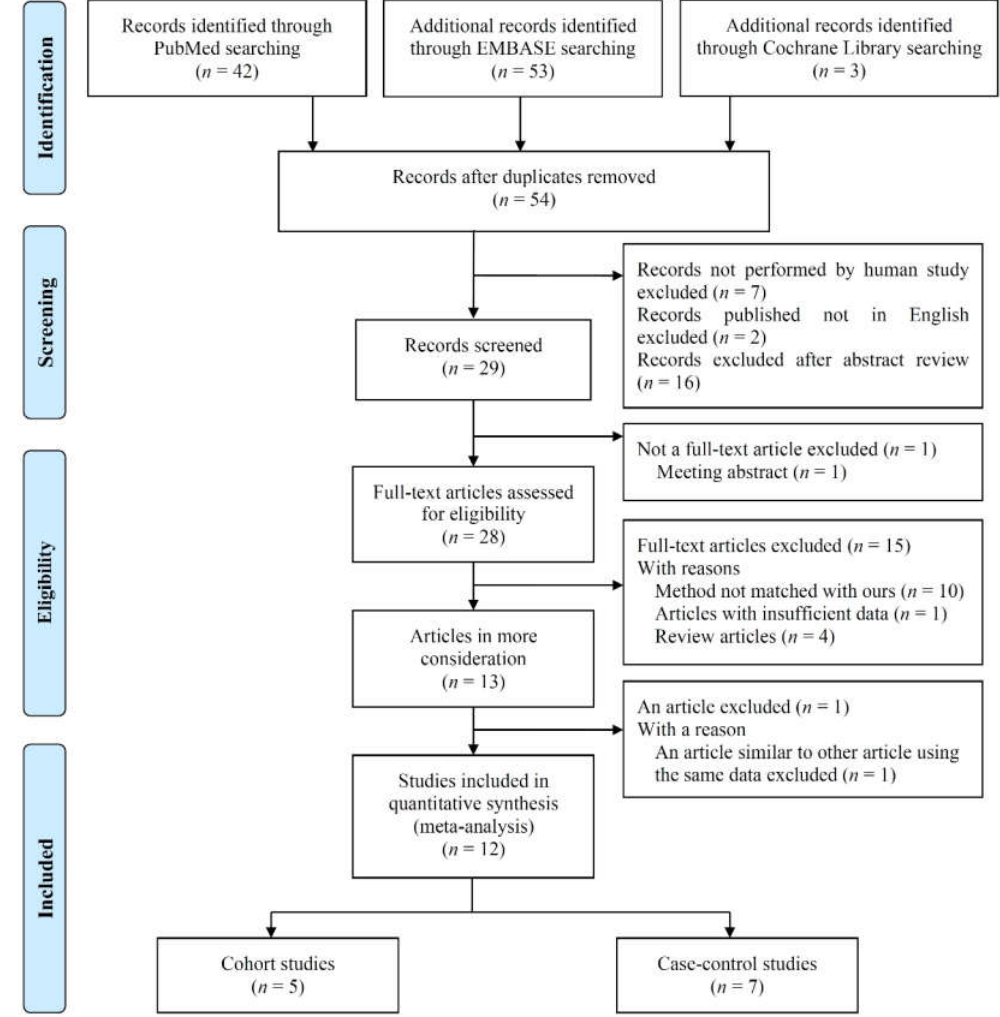
Figure 1. PRISMA 2009 flow diagram of the study selection process for this meta-analysis.